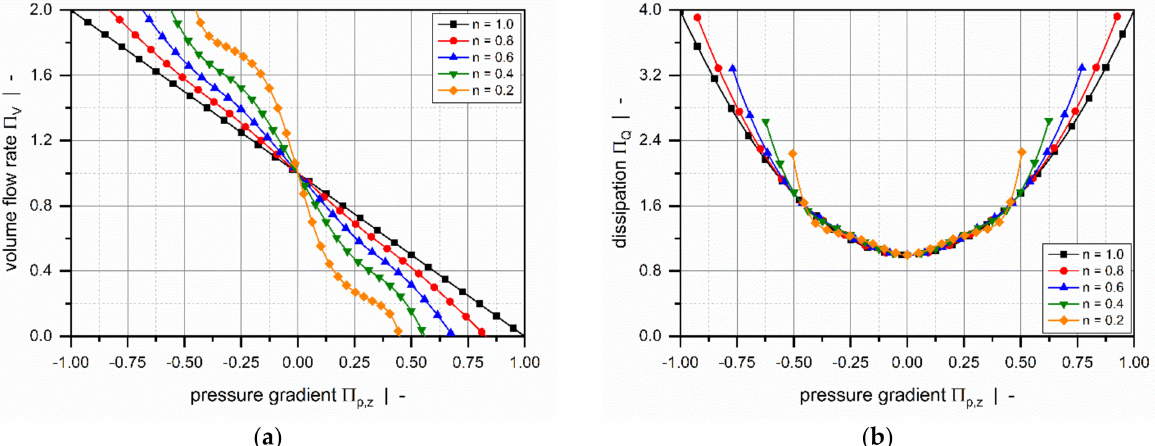
Figure 7. Influence of the power-law index on the fully developed one-dimensional down-channel flow of a power-law fluid under isothermal conditions. The dimensionless volume flow rate Π V as a function of the dimensionless pressure gradient Π p , z ( a ), and the dimensionless dissipation Π Q as a function of the dimensionless pressure gradient Π p , z ( b